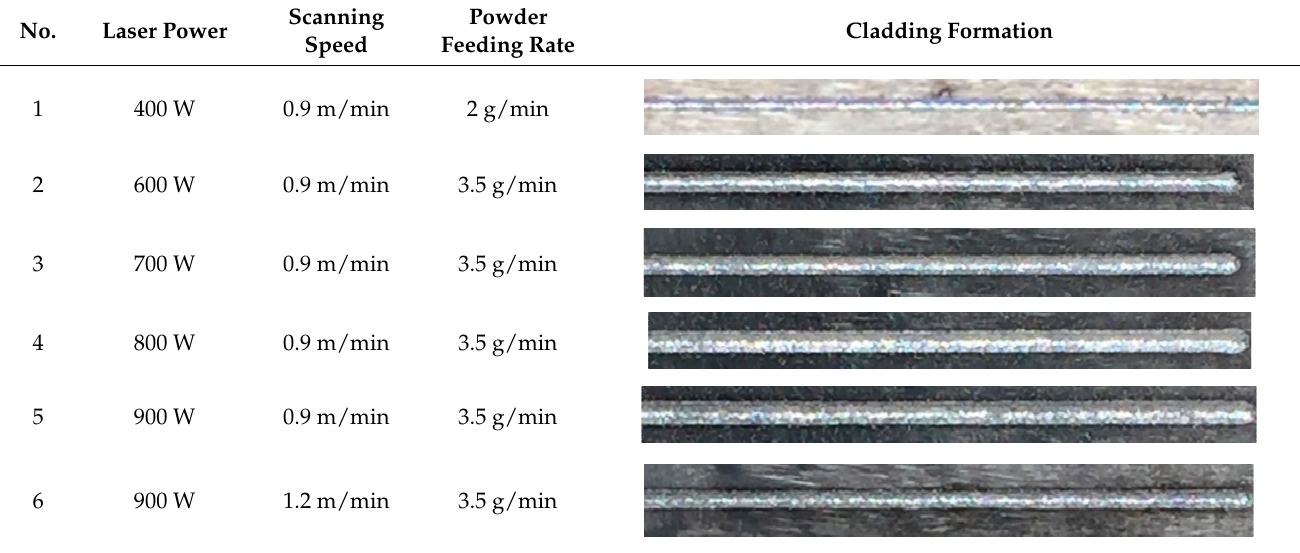
Table 5. Repairing formation in single pass under laser spot diameter of 2.5 mm.